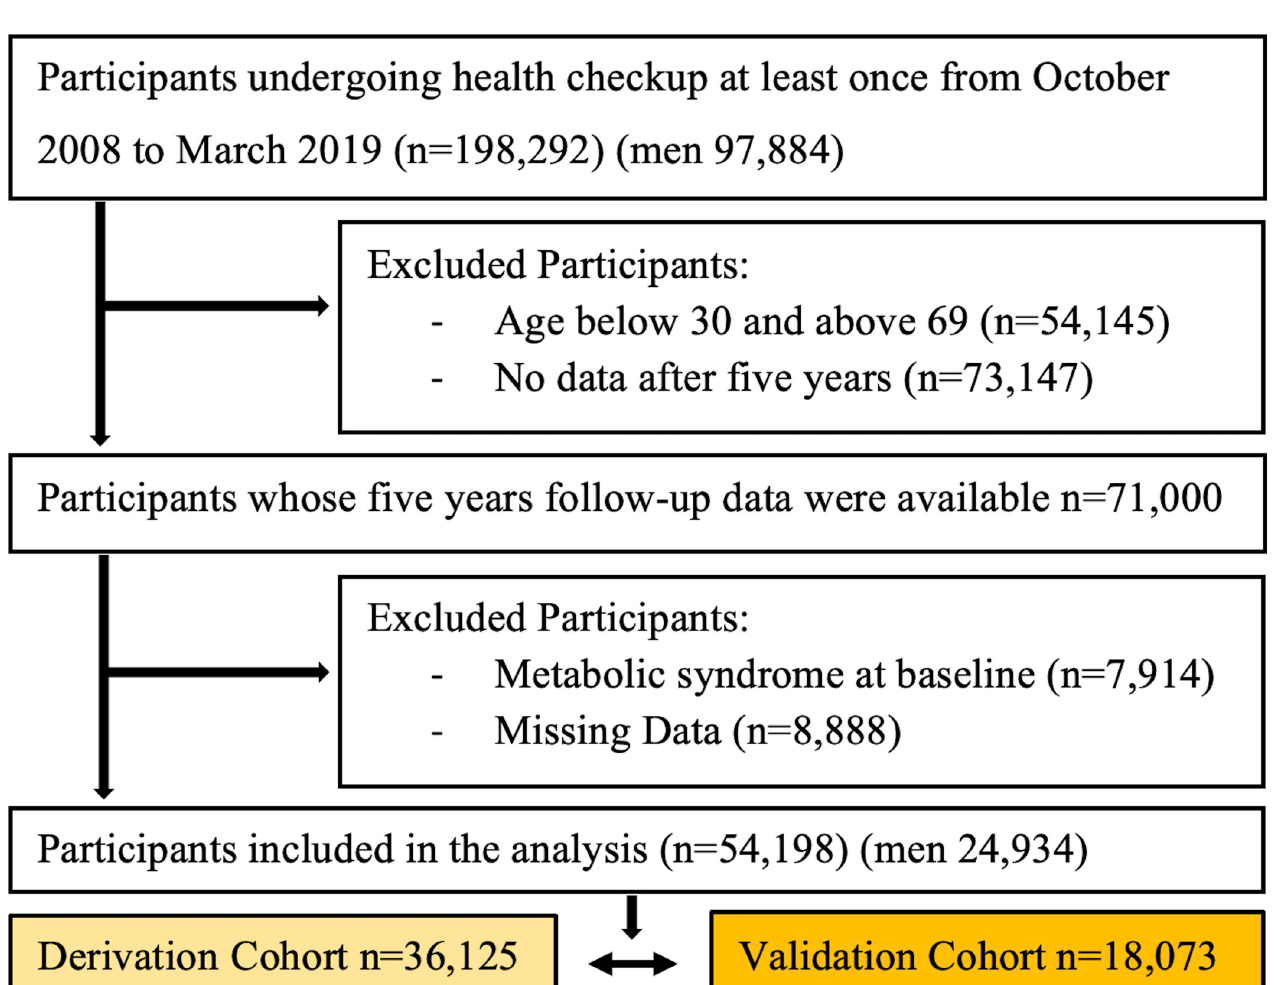
Fig 1. Study population. A total of 54,198 (men 24,934) selected participants classified into derivation cohort (n = 36,125) and validation cohort (n =